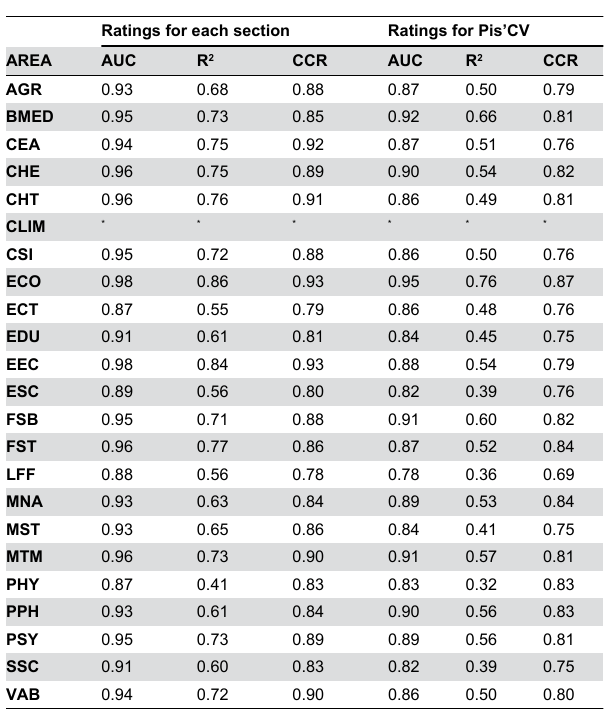
Table 3. Prediction ability measures of the logistic regression analysis to model the concession of research grants.